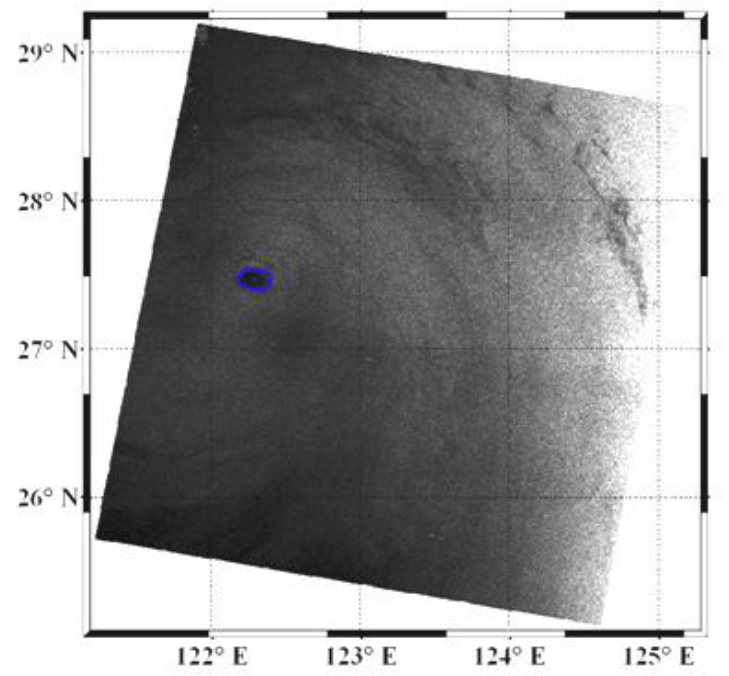
Figure 7. Envisat SAR image with the eye boundaries delineated using wavelet analysis for Typhoon Khanun on 11 September 2005.